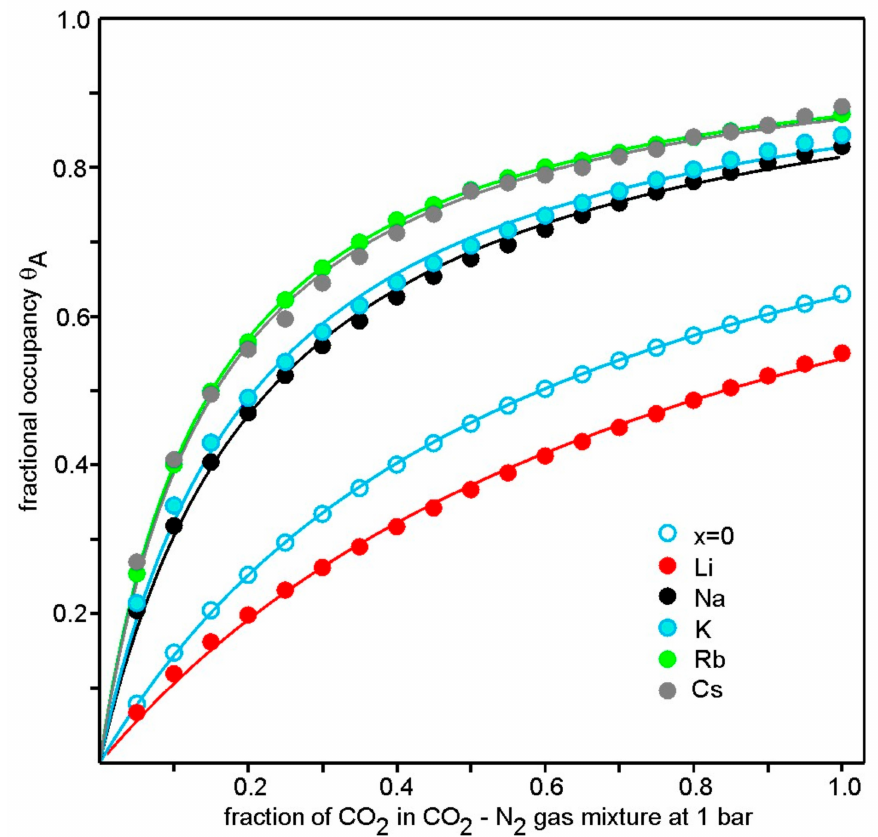
Figure 8. Adsorption isotherms from TGA data for A 2 / 3 Cu[Fe(CN) 6 ] 2 / 3 compounds and Cu[Fe(CN) 6 ] 2 / 3 ( x = 0). The temperatures were 20 ± 1 ◦ C. The solid lines are fits to the Langmuir expression θ A = V / V m = K / (1 + K · p · p eq eq A A